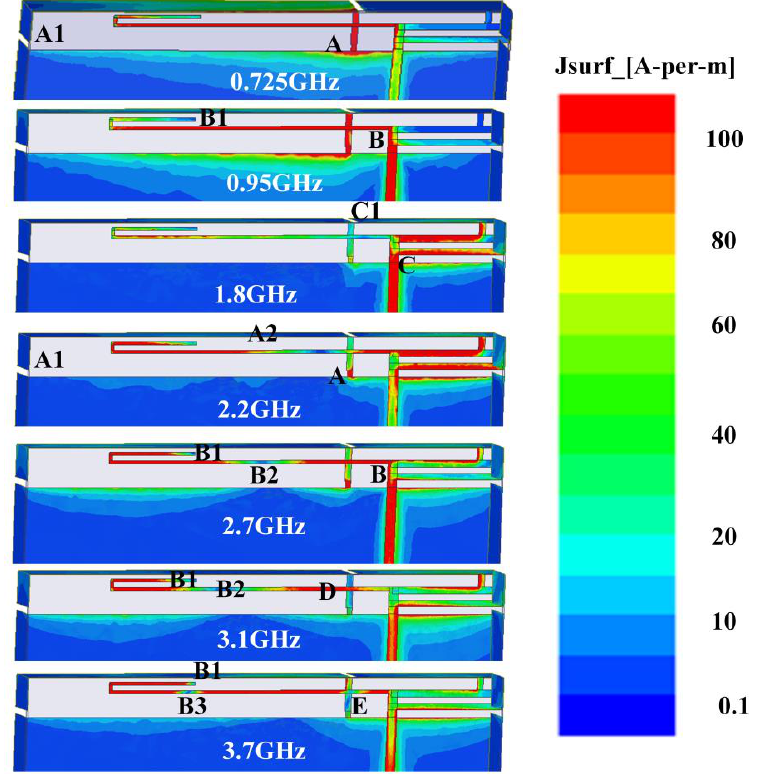
Figure 3. The simulated current distributions of the proposed antenna.